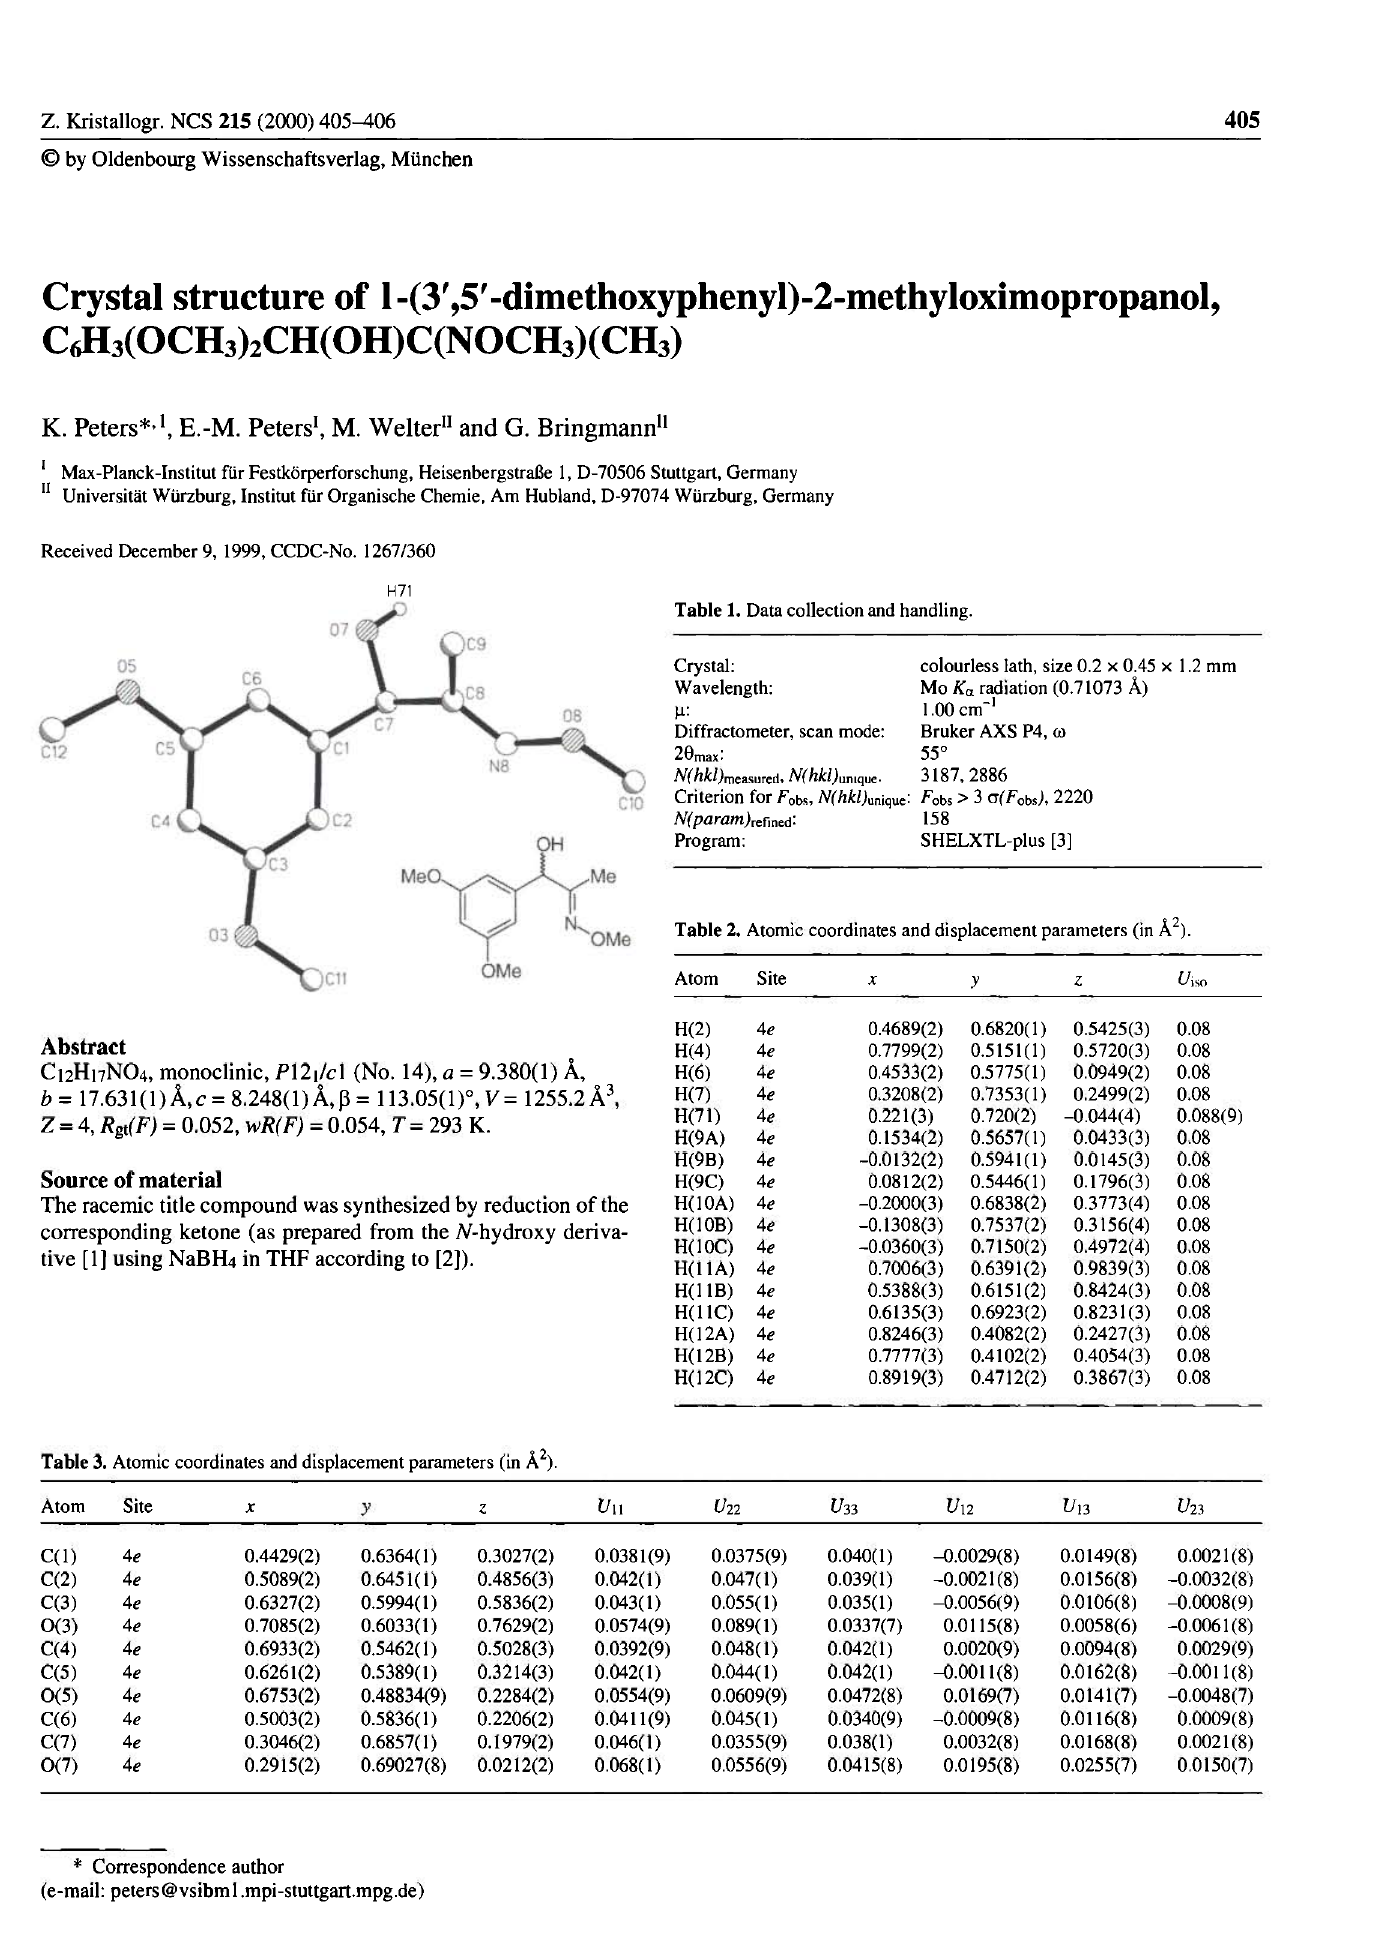
Table 3. Atomic coordinates and displacement parameters (in A 2